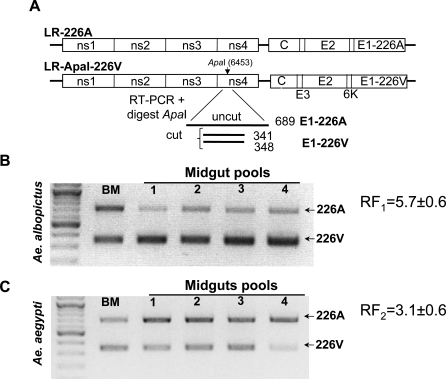
Schematic Representation of Competition Experiments (A) and Competition between LR-ApaI-226V and LR-226A Viruses for Colonization of Midgut cells of Ae. albopictus (B) and Ae. aegypti (C) Mosquitoes107 pfu of LR-ApaI-226V and LR-226A were mixed and orally presented to Ae. albopictus (B) and Ae. aegypti (C). Viral RNAs were extracted from four pools of eight to ten midguts at 7 dpi. RT-PCR products were digested with ApaI, separated in 2% agarose gel, and gels were stained using ethidium bromide.BM - initial ratio of LR-ApaI-226V and LR-226A in blood meal samples. 1–4 ratio of LR-ApaI-226V and LR-226A RNA in four independent replicas of the eight to ten midguts per replica.Relative fitness (RF1) of LR-Apa-226V to LR-226A was calculated as a ratio between 226V and 226A bands in the sample, divided by the control ratio between 226V and 226A in the blood meal.Relative fitness (RF2) of LR-226A to LR-Apa-226V was calculated as a ratio between 226A and 226V bands in the sample, divided to the control ratio between 226A and 226V in the blood meal.Results expressed as the average of four replicas ± standard deviation (SD).